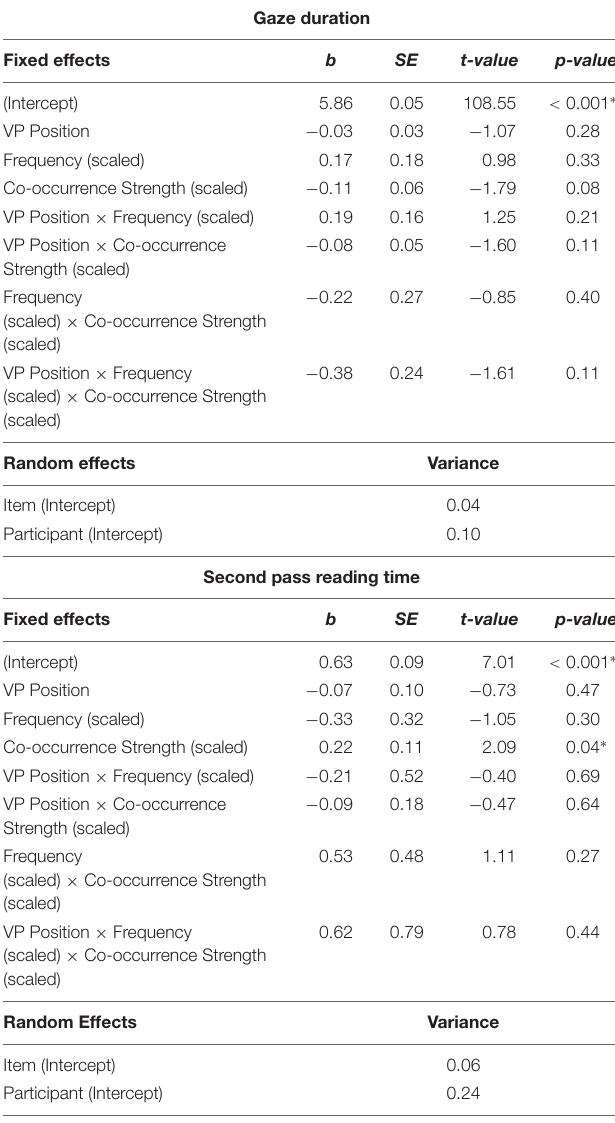
TABLE 3B | Experiment 1, Analysis 2 item-specific model outputs at the post-VPC